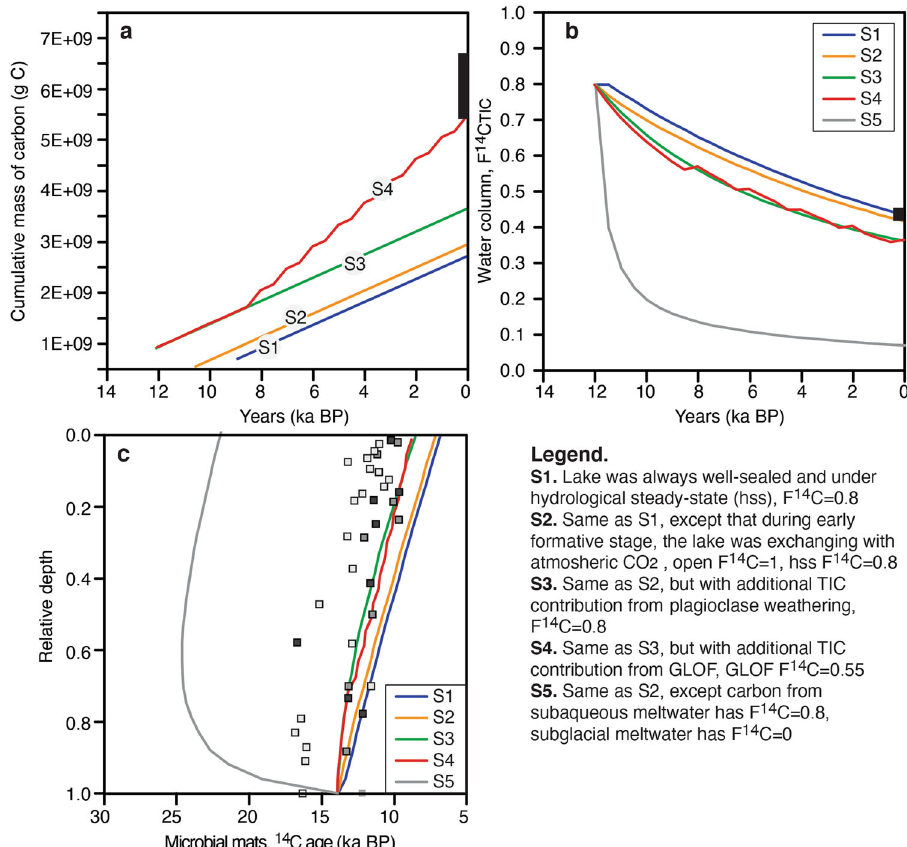
Fig. 6 Carbon mass balance and numerical modeling of 14 C evolution in the water column and microbial mats of Lake Untersee, Antarctica. a Cumulative mass of carbon (g C) accumulating in Lake Untersee ’ s oxic water column and microbial mats under four different scenarios. Black bar is the amount of carbon stored in Lake Untersee. b Evolution of F 14 C TIC in Lake Untersee under four different scenarios. Black bar is the measured F 14 C TIC in the lake. c Evolution of 14 C age of microbial mats. The 14 C pro fi le in the mats assumes the mats are solely using the TIC in lake water as their carbon source, and 14 C ages re fl ect the evolution of 14 C TIC in the water column. White, black, and gray boxes, respectively indicate radiocarbon ages of microbial mat laminae in cores #1, #2, and